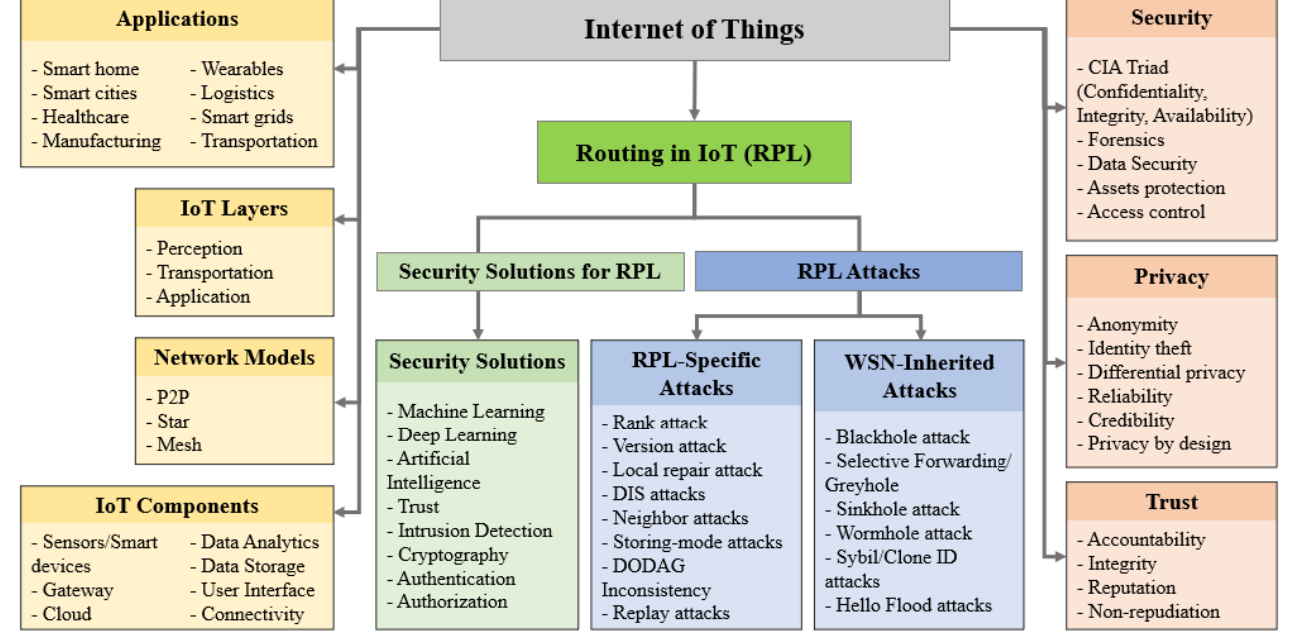
Figure 1. An Overview of IoT Applications, Layers, Network Models, Components, Security, and RPL Attacks.